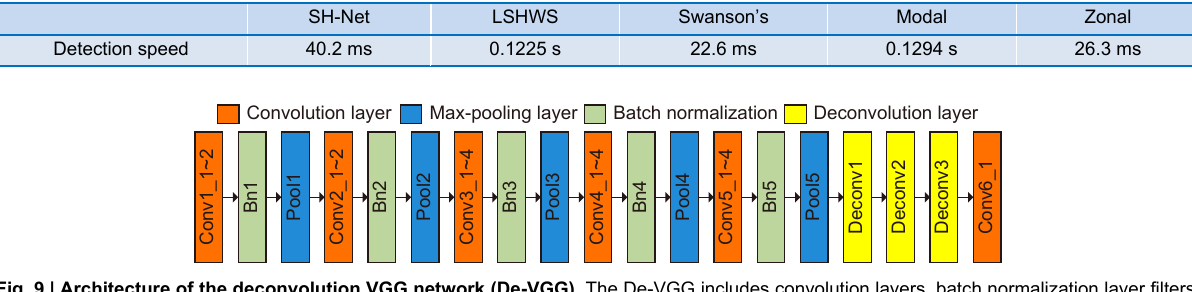
Fig. 9 | Architecture of the deconvolution VGG network (De-VGG). The De-VGG includes convolution layers, batch normalization layer filters, activation function ReLU, and deconvolution layers. The fully connected layers are removed, as the high output order slows down the calculation speed, but the deconvolution layer will not. Figure reproduced from ref. 80 , under a Creative Commons Attribution License 4.0. Table 4 | The inference time of De-VGG compared with SPGD. Table reproduced from ref. 80 , MDPI. SPGD (ms) De-VGG (ms) D / r 0 =6 (RMS=0.0703λ) D / r 0 =10 (RMS=0.0703λ)